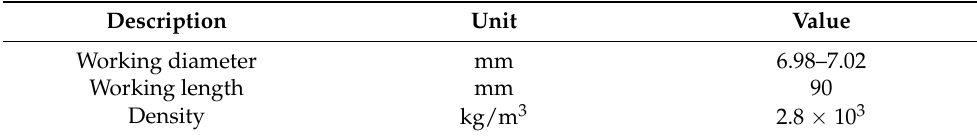
Figure 1. Dimensions and geometry of the specimen. Table 1. Dimensions of the specimen.